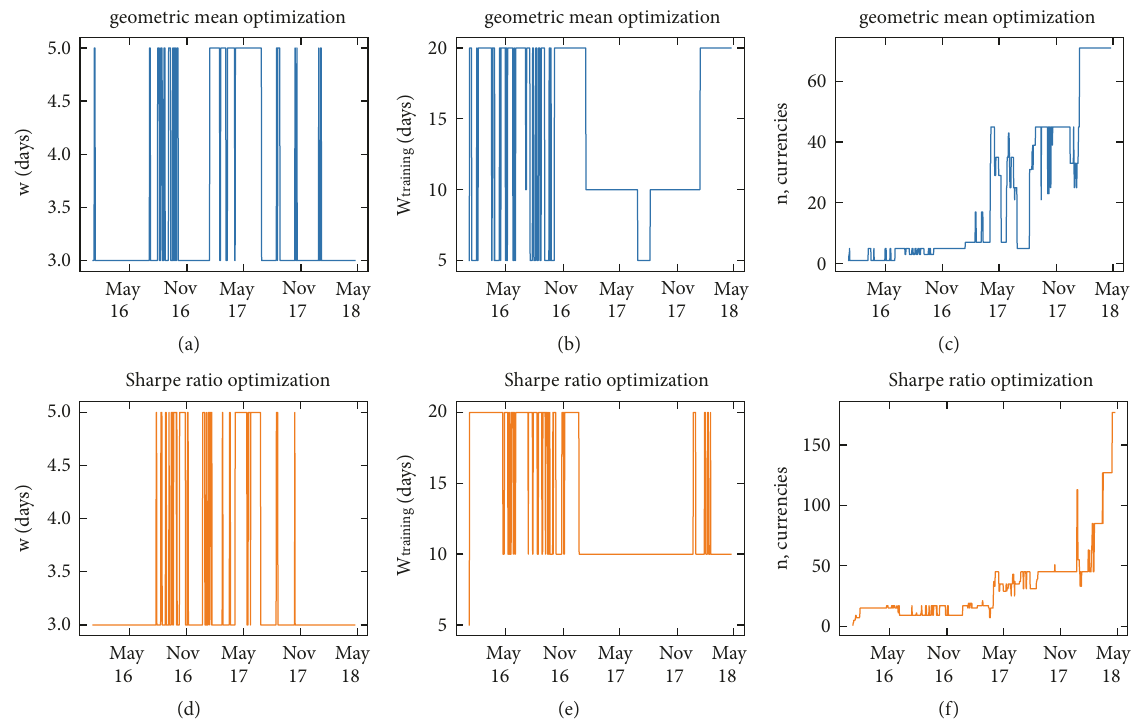
Figure 10: Method 2: parameters optimisation. The sliding window 𝑤 (a, d), the training window 𝑊 𝑡𝑟𝑎𝑖𝑛𝑖𝑛𝑔 (b, e), and the number of currencies 𝑛 (c, f) chosen over time under the geometric mean (a, b, c) and the Sharpe ratio optimisation (d, e, f). Analyses are performed considering prices in BTC.